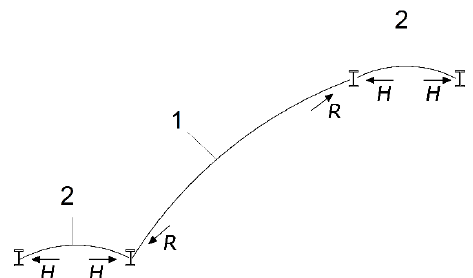
Figure 3. Calculation scheme of masonry stairs with segmental vault and arched staircase slab: 1—arched staircase slab; 2—landings.